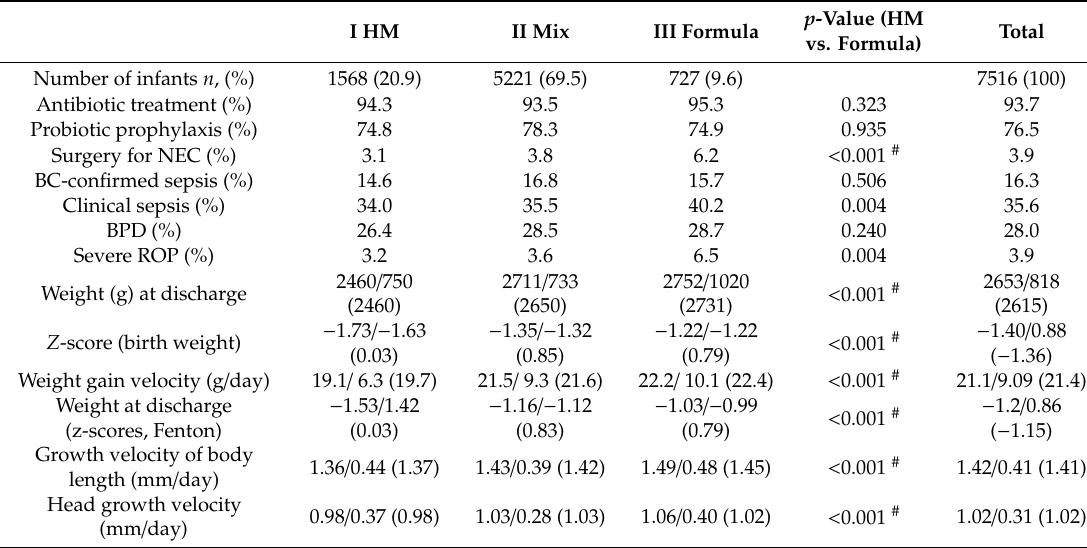
Table 4. Treatment, outcomes, and growth parameters of the GNN cohort stratified to type of milk feeding.